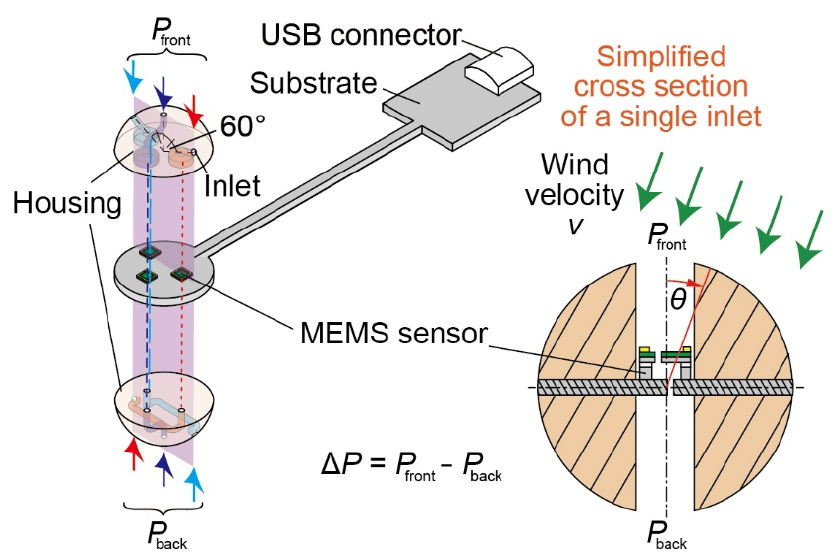
Figure 2. Schematic diagram of the airflow vector sensor component. The sensor is composed of a substrate with three MEMS DP sensor chips and spherical housings with airflow channels. Each MEMS DP sensor measures the DP between the corresponding two channels.